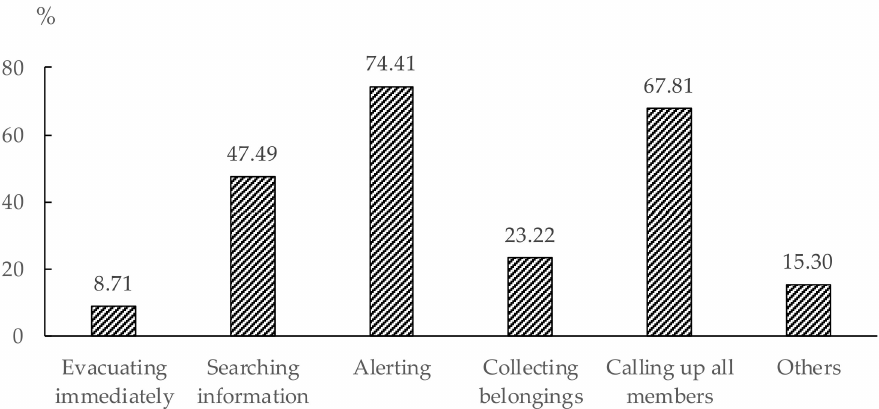
Figure 4. Statistical result of the selection of di ff erent pre-evacuation